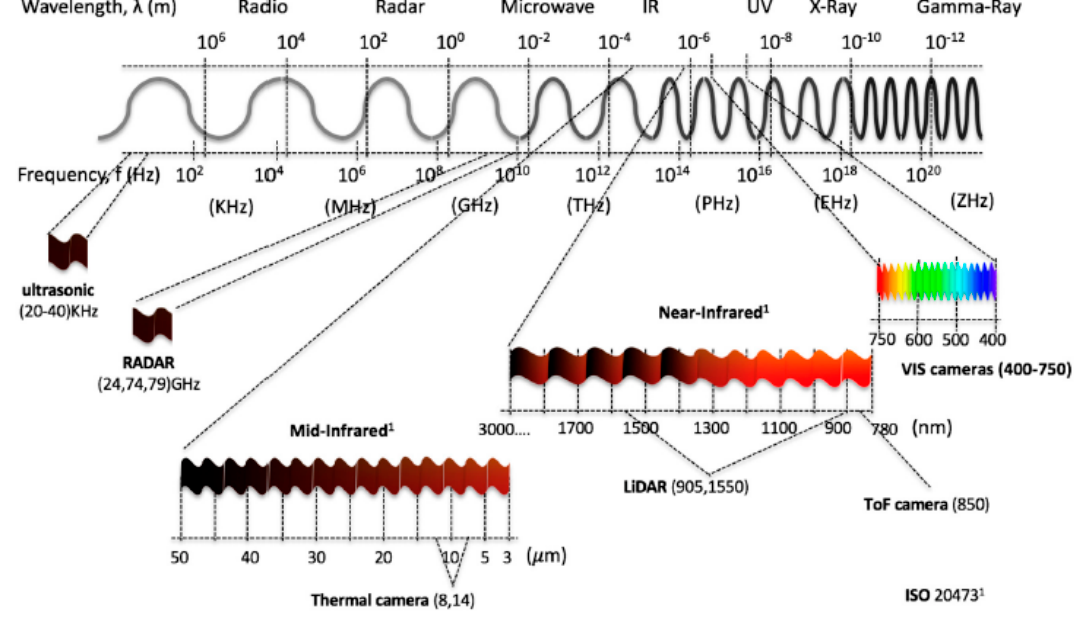
Figure 1. Electromagnetic spectrum according to ISO 20473 [57].